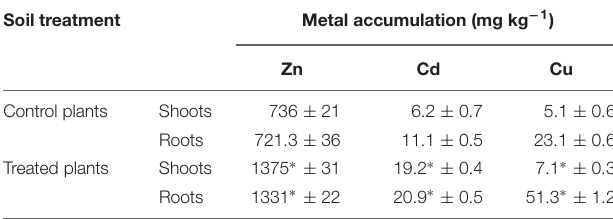
TABLE 1 | Heavy metal accumulation in the shoots and roots of Sinapis alba L. growing in the control soil and soil inoculated with Brevibacterium casei MH8a.